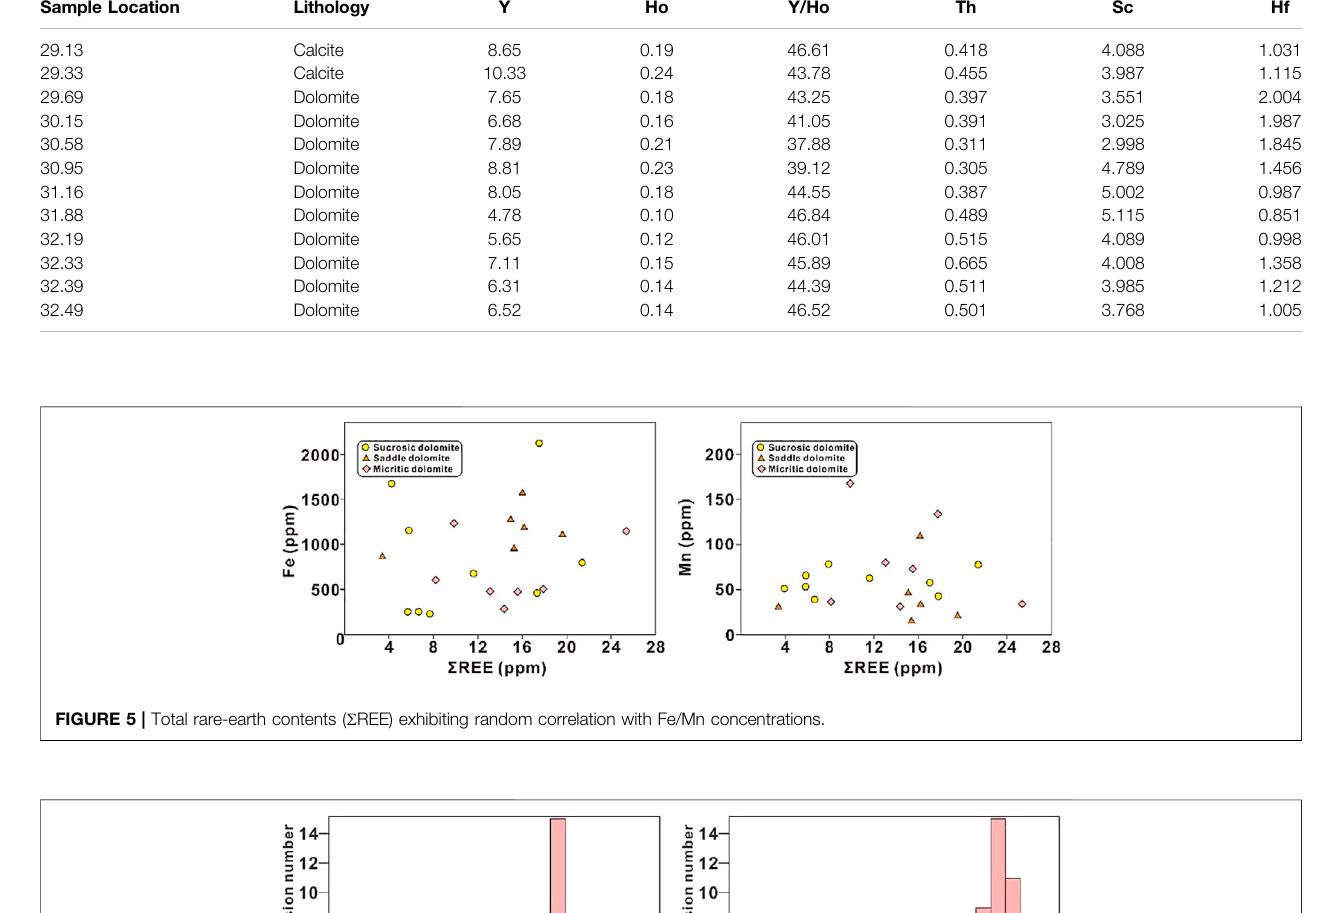
TABLE 1 | Statistics of concentrations of trace elements (ppm) from the studied interval. Sample Location